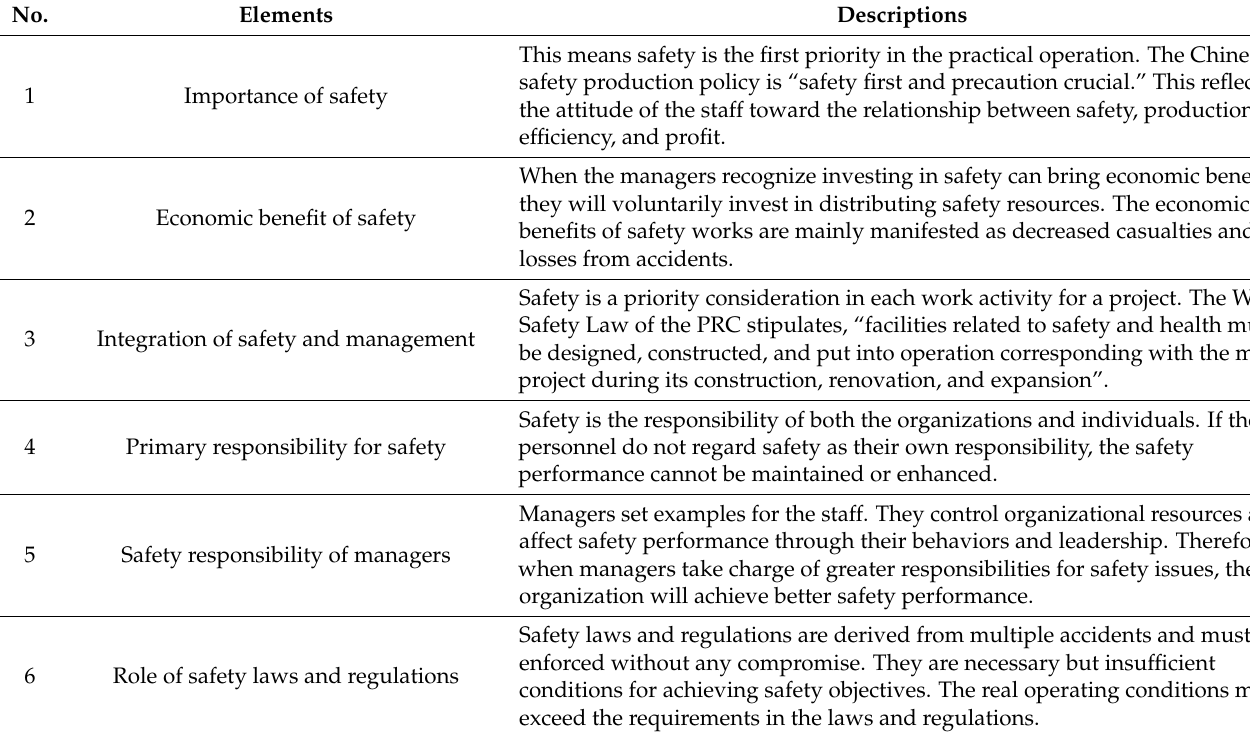
Table 3. Key elements in the construction of safety